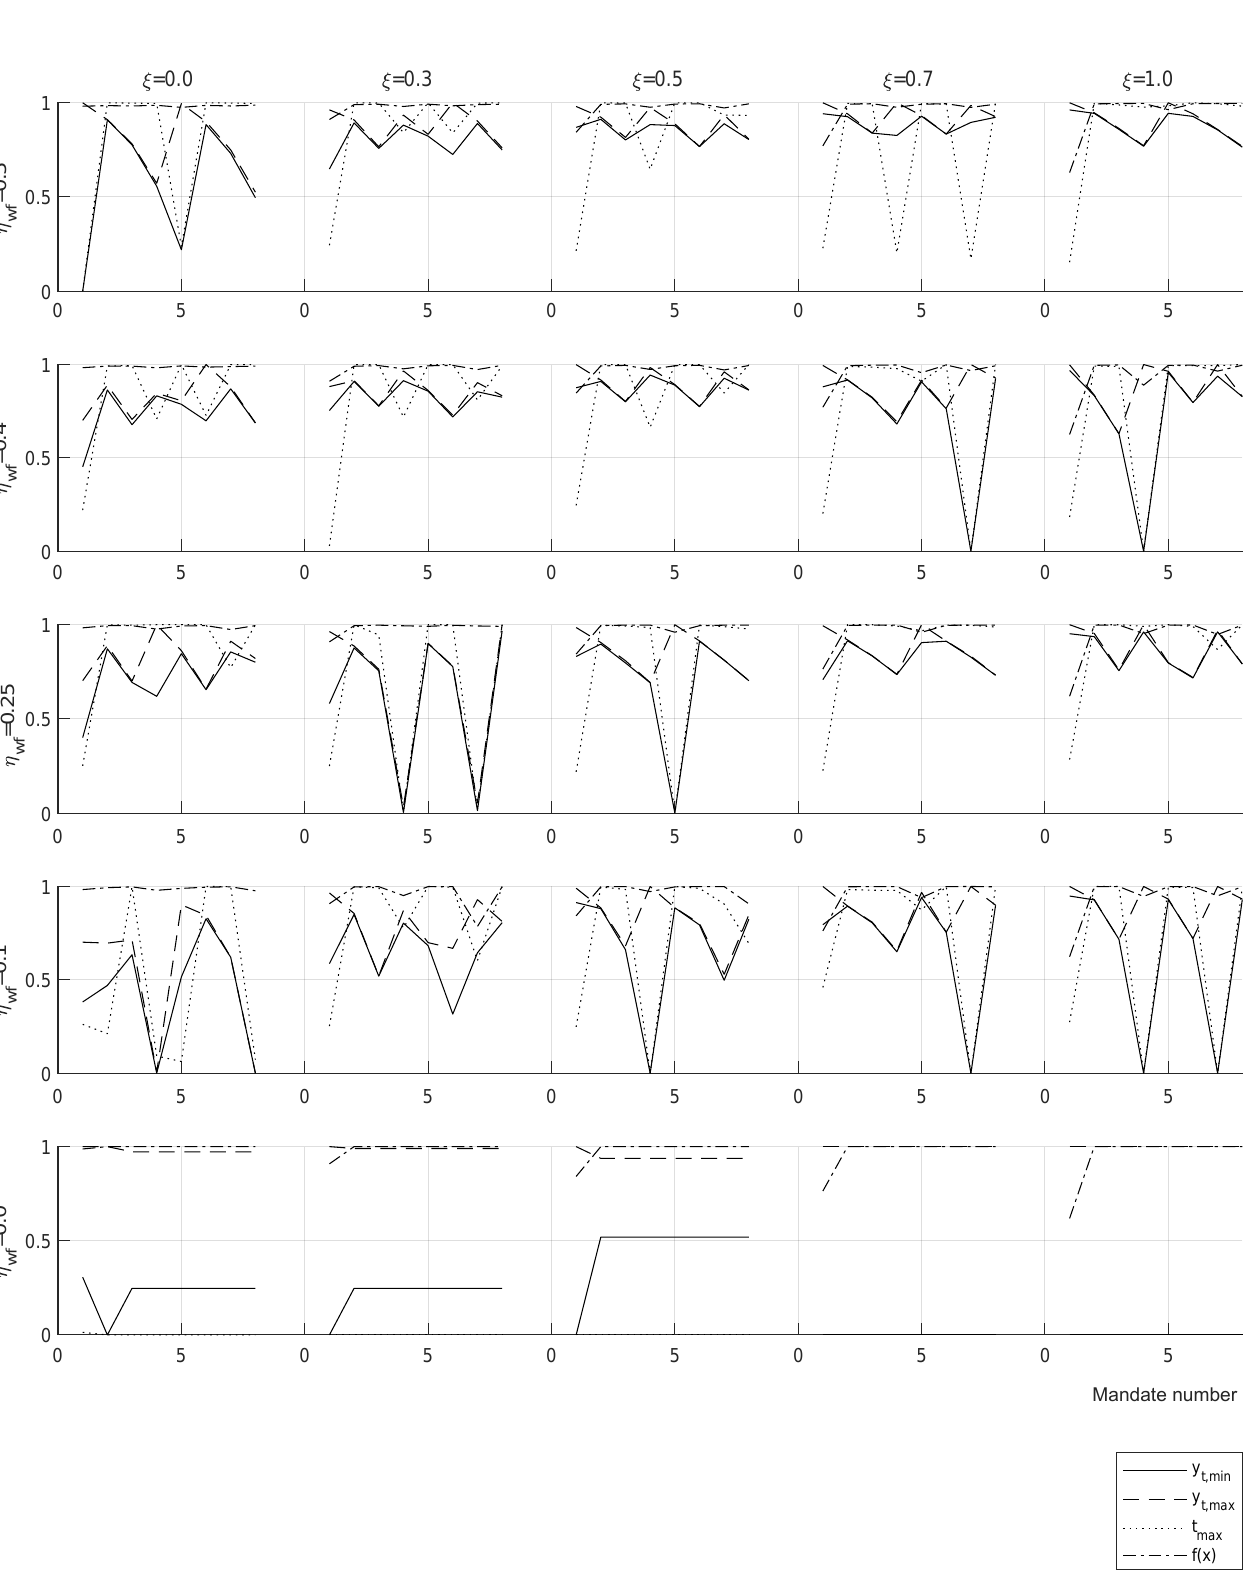
Figure A2. Tax policy evolution under yardstick vote during eight mandates for a series of welfare efficiency values η wf and tax disincentive ξ . Median criterion. Mandate length: 4